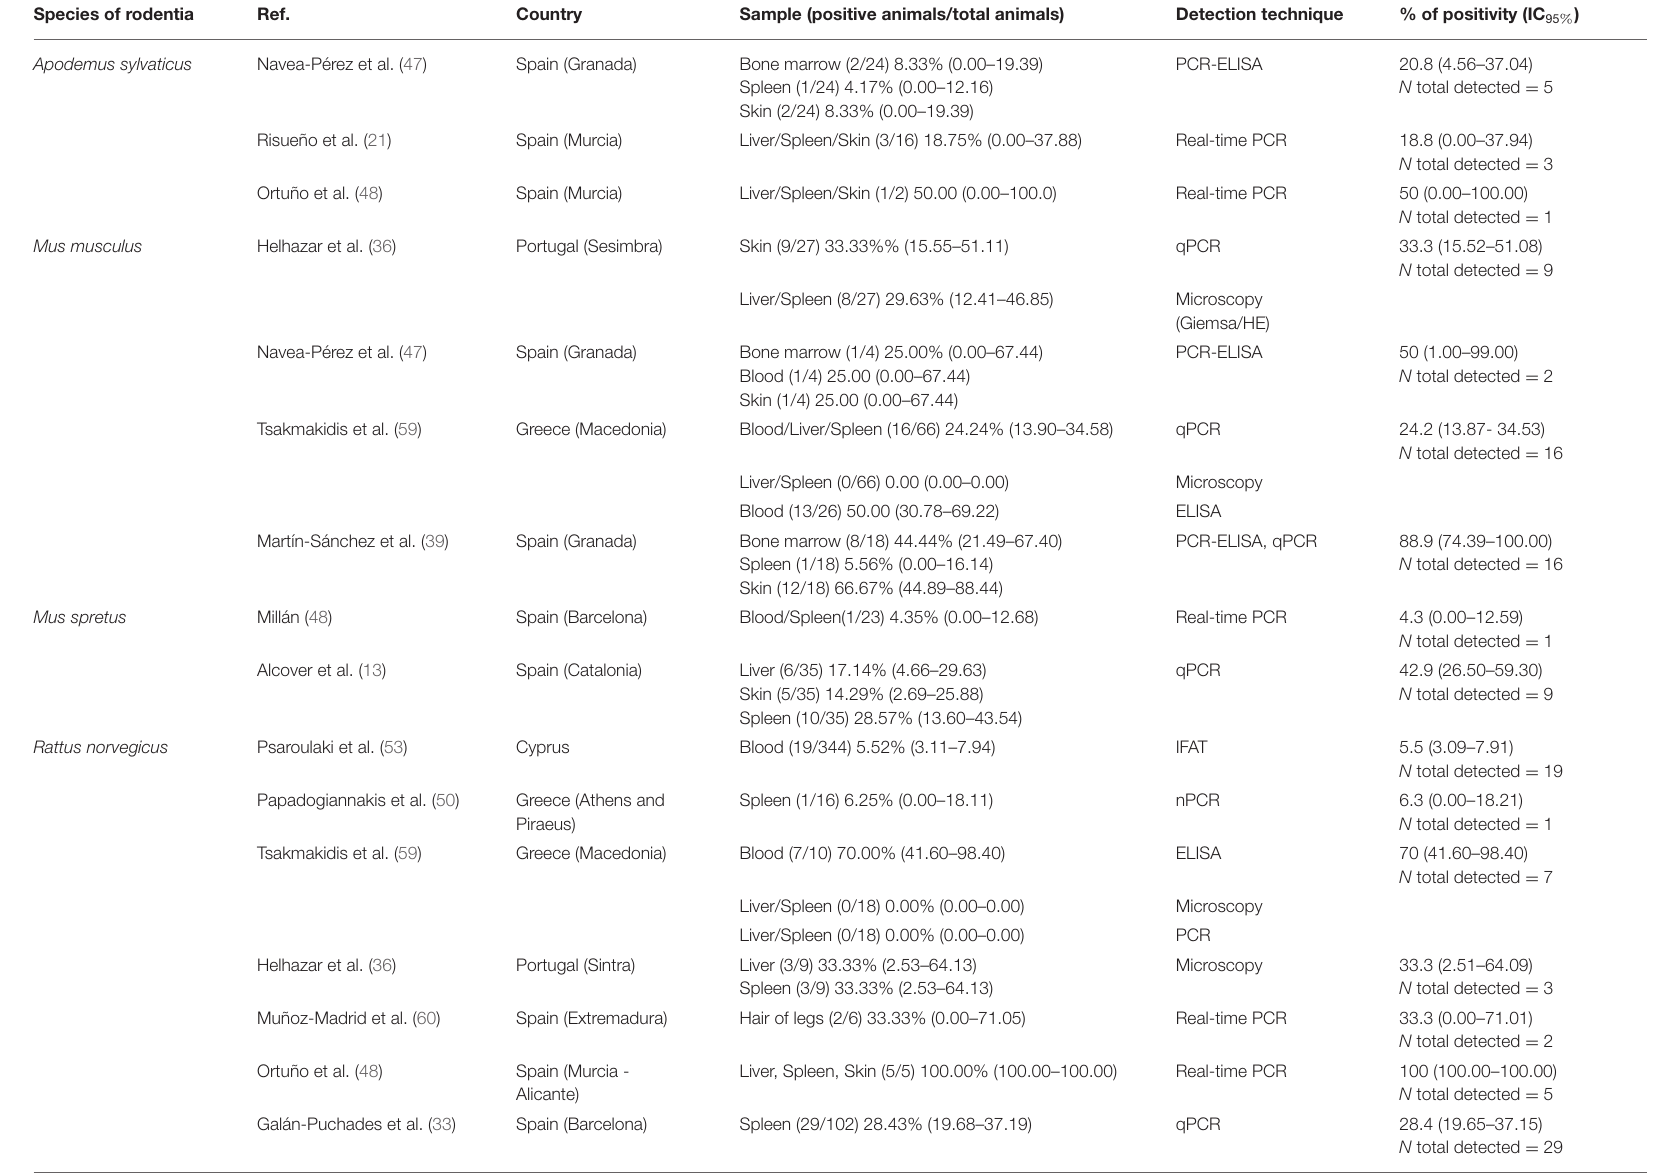
TABLE 5 | Studies carried out in Europe published between January 1 2001 and December 31